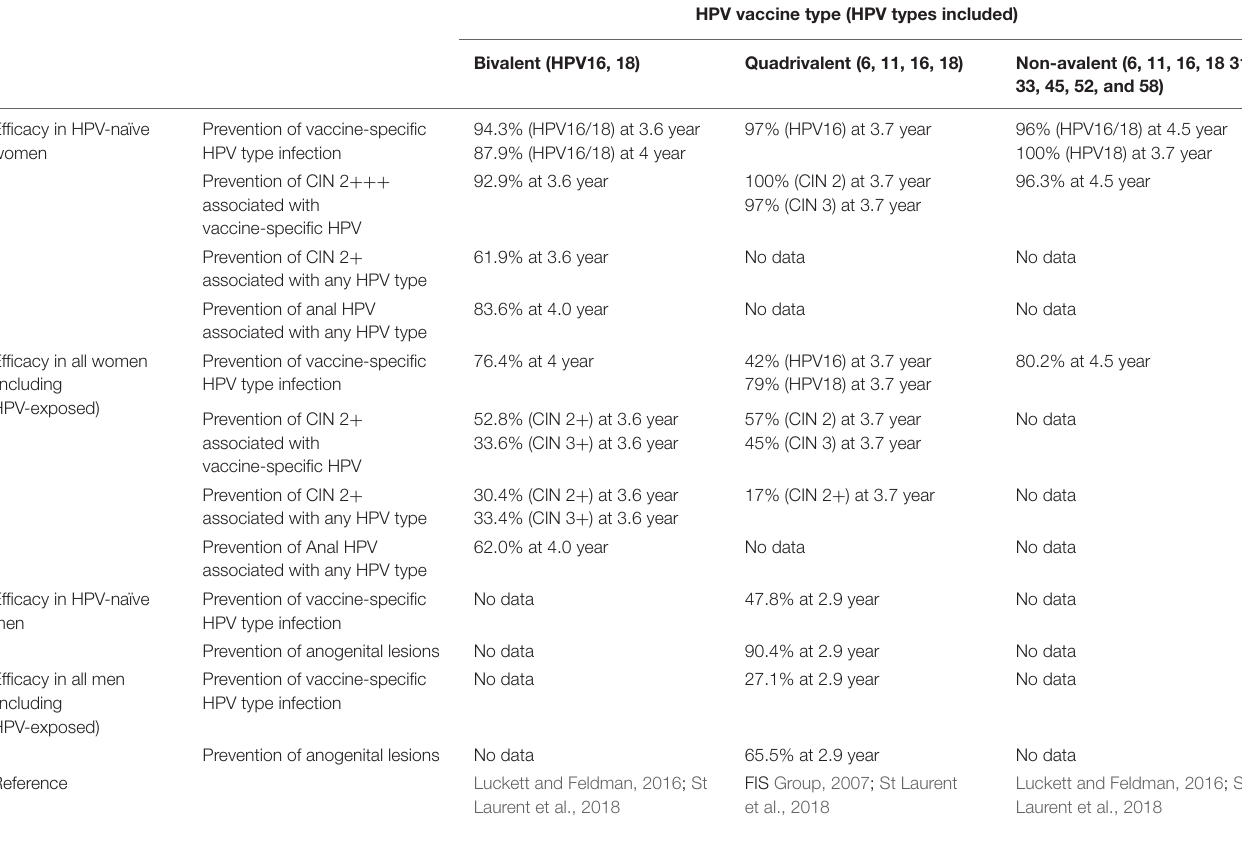
TABLE 3 | Efficacy of HPV vaccines